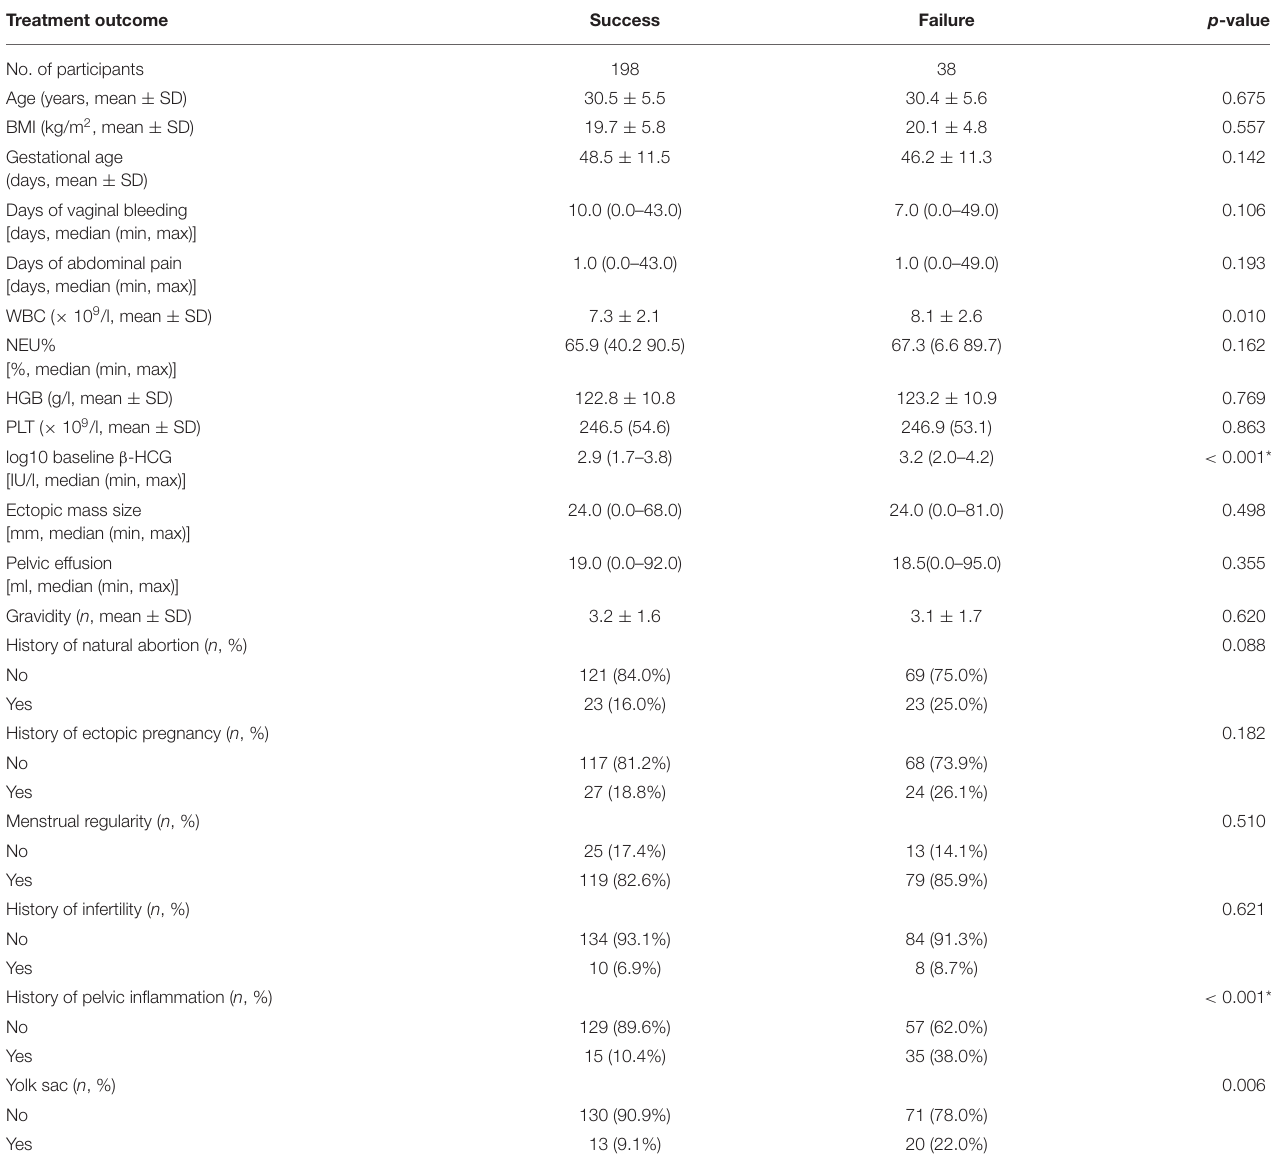
TABLE 1 | Baseline characteristics of participants. Treatment outcome